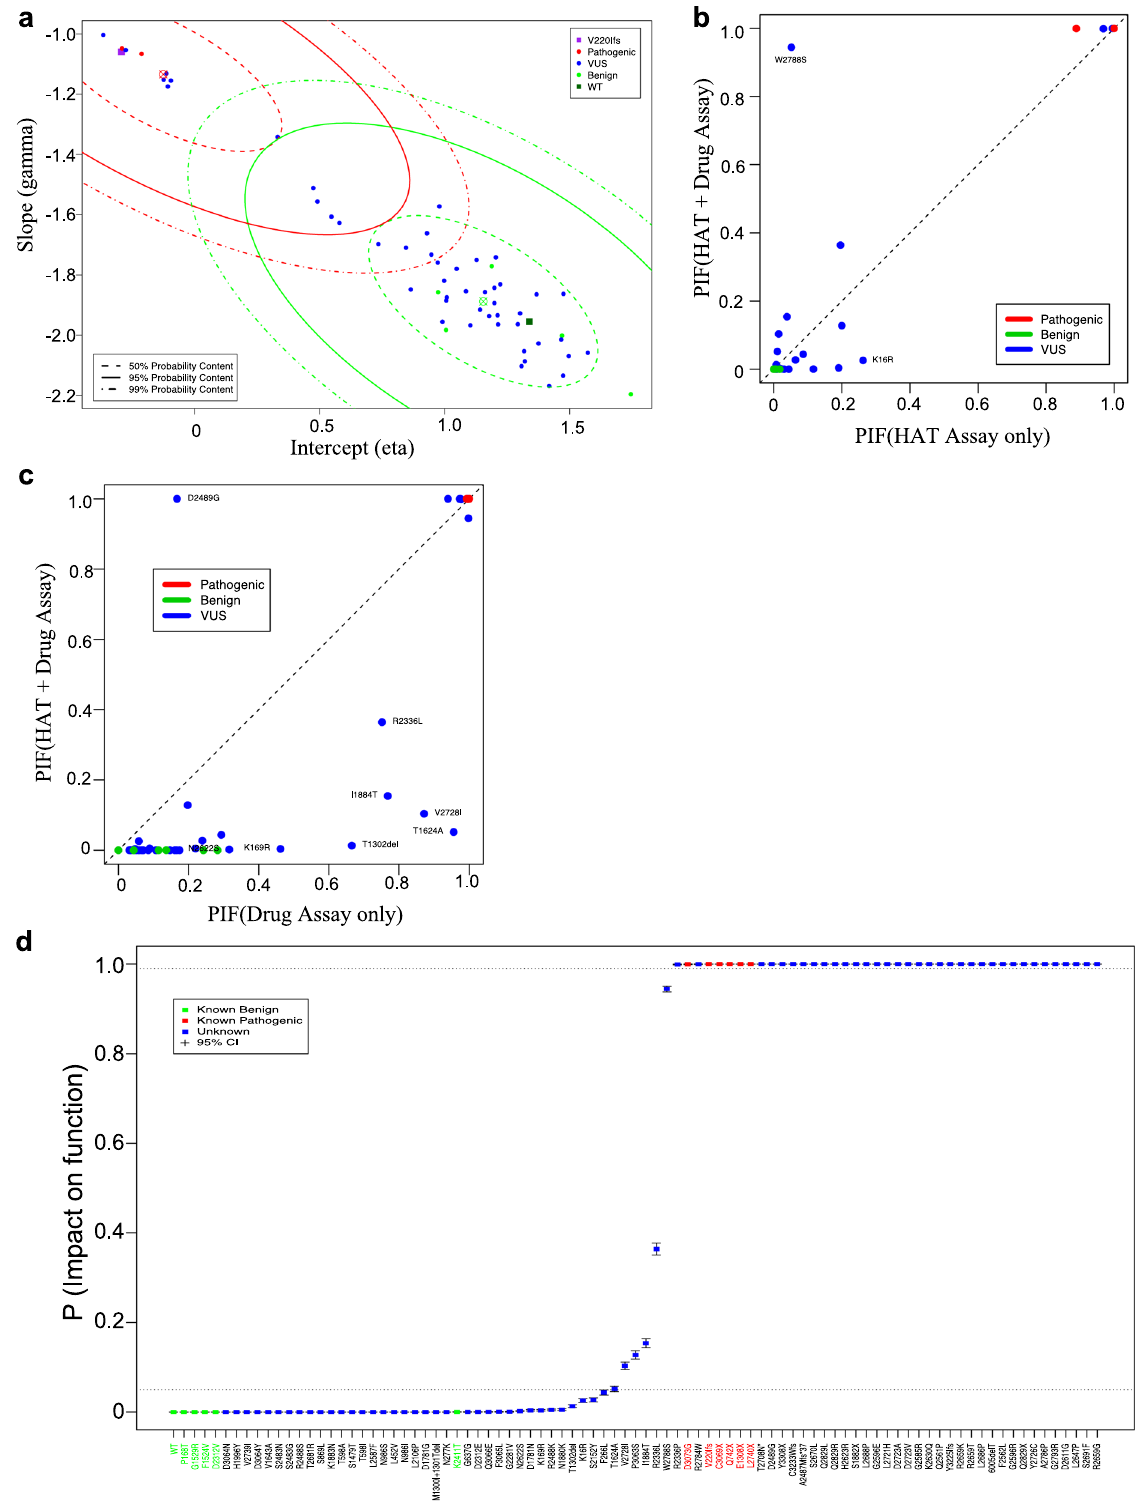
Fig. 4 Classi fi cation parameters and estimates from the model combining the cell survival and drug sensitivity data. a Slope vs. intercept scatter plot for the combined model. b Plot of the PIF from the HAT model ( x -axis) against the PIF from the combined model ( y -axis). c Plot of the PIF from the drug assay model ( x -axis) against the PIF from the combined model ( y -axis). d Plot showing the estimated PIFs plot from the combined VarCall model of HAT survival and drug sensitivity data, depicted in increasing order. Posterior mean estimates and represented as dots and the whiskers extend from the lower to upper limits of 95% posterior credible